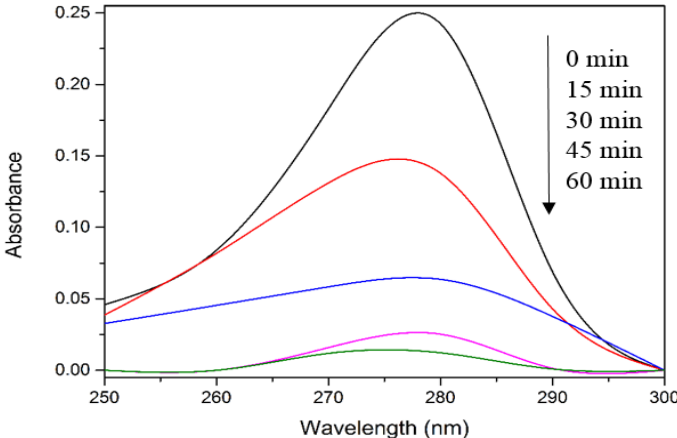
Figure 2. UV-vis spectra of 4-CPA during photocatalytic degradation process. Conditions: ZnO loading = 0.03 g; [4-CPA] = 30 mg/L; pH =